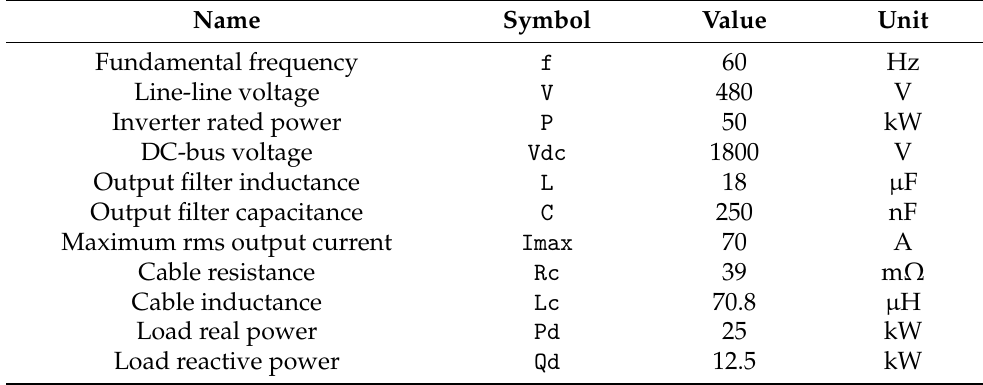
Table 5. Hardware parameters.